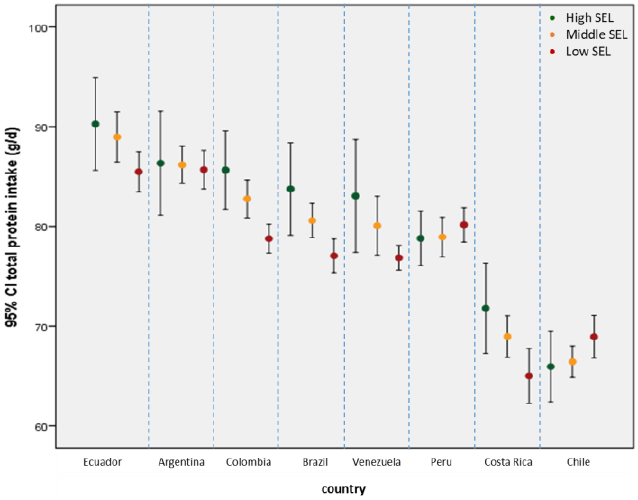
Figure 3. Mean daily protein intake (g/day) by socio-economic level by ELANS countries.